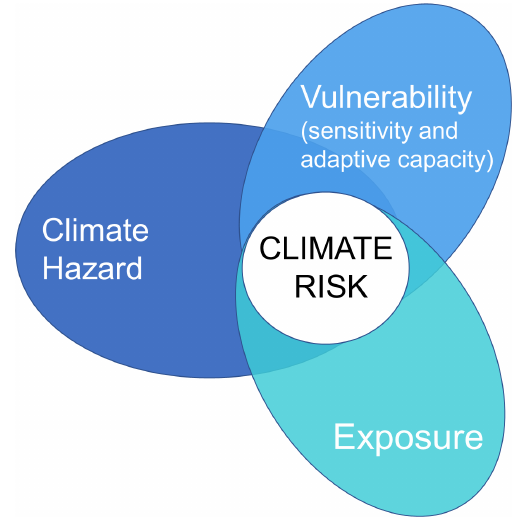
Figure 1. IPCC’s conceptual framework of climate risk (adapted from IPCC,